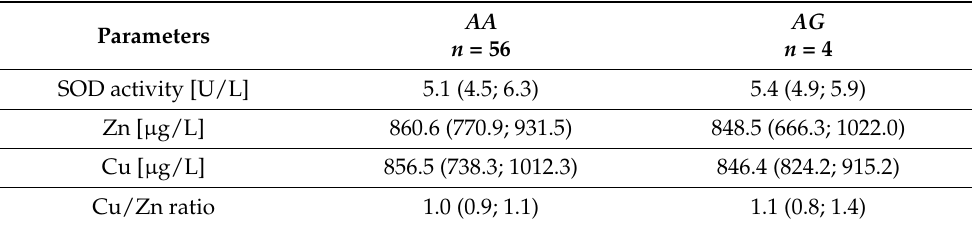
Table 3. The activity of SOD1 and Zn, Cu concentration as well as Zn/Cu ratio in the group of women with PCOS divided according to genotype of rs2070424.